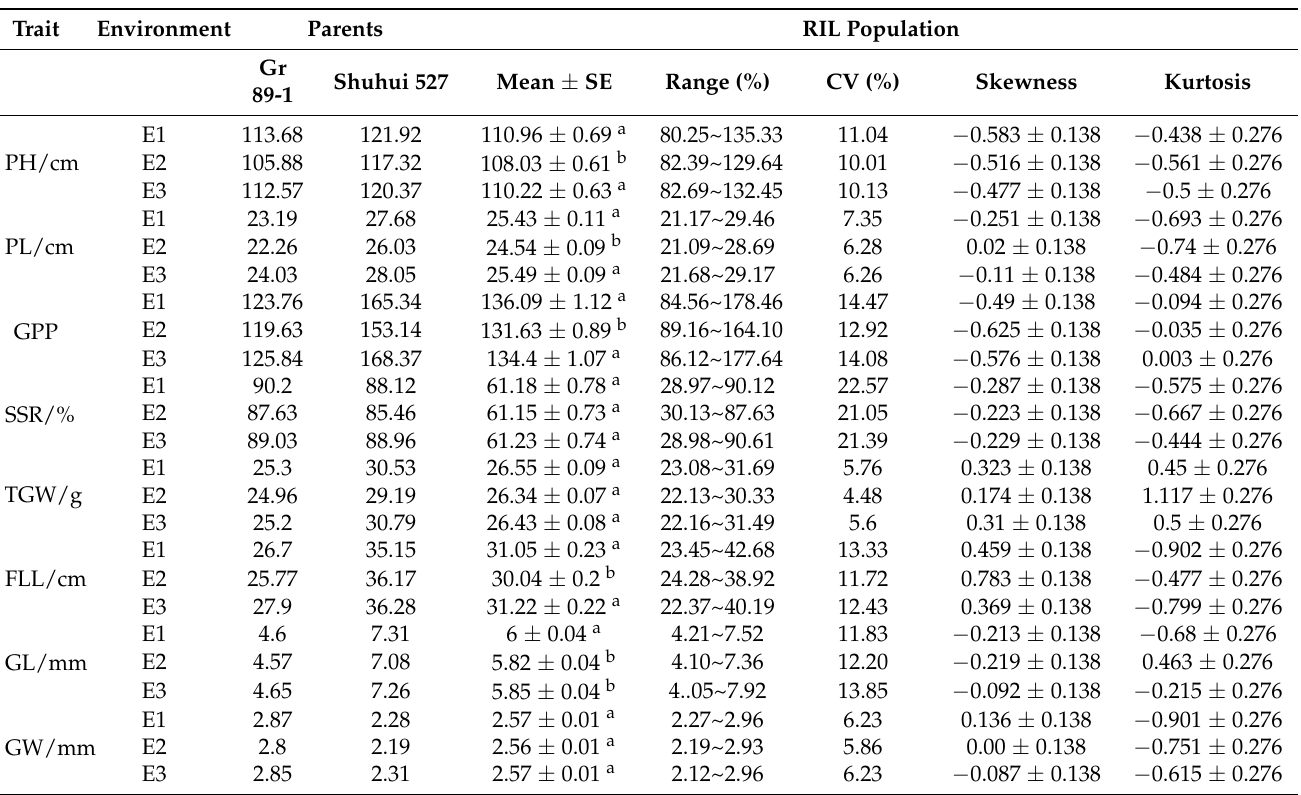
Table 1. Phenotypic variation of 8 agronomic traits in different years and locations in F 9 RIL S of Gr 89-1 × Shuhui